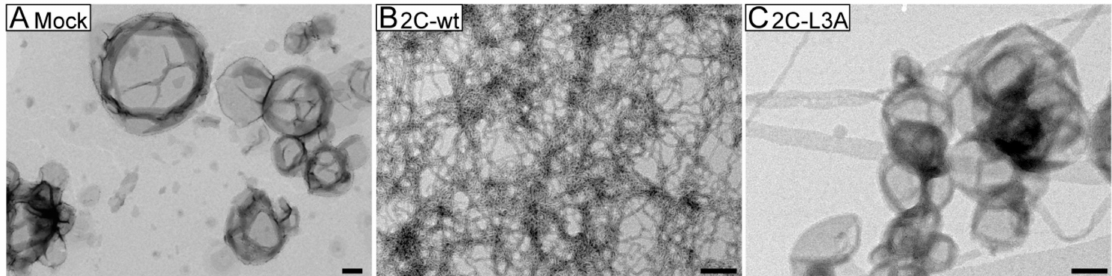
Figure 4. Remodeling of negatively charged vesicles by 2C peptides; 1000 nm negatively charged POPG vesicles were not treated (Mock; ( A )) or treated with 2C-wt ( B ) or 2C-L3A ( C ) peptides. The peptide concentration was 50 µ M and the lipid concentration was 500 µ M. Scale bar = 200 nm.